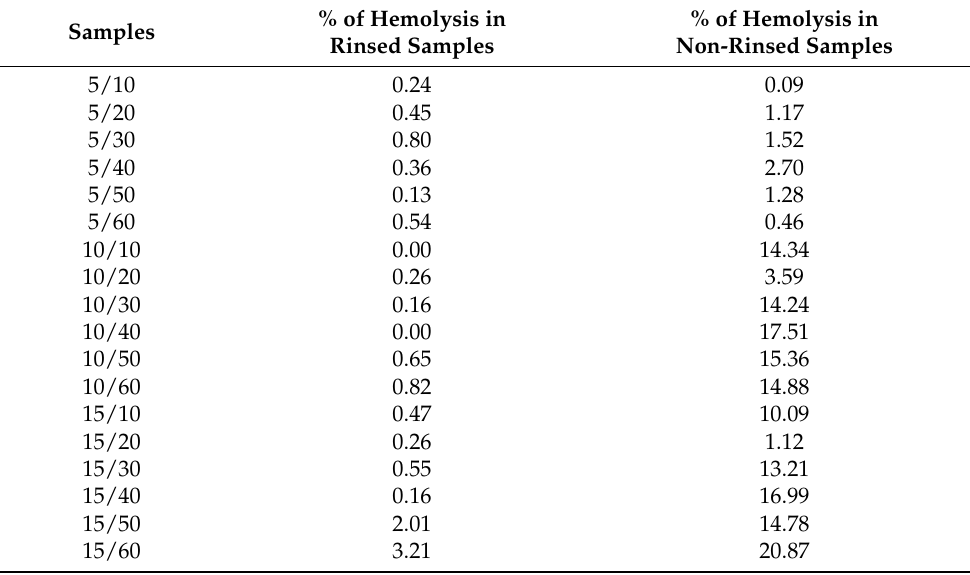
Table 7. Toxicity to human red blood cells measured as % of hemolysis in nonwovens modified using acetic acid solution in ethanol—procedures with and without